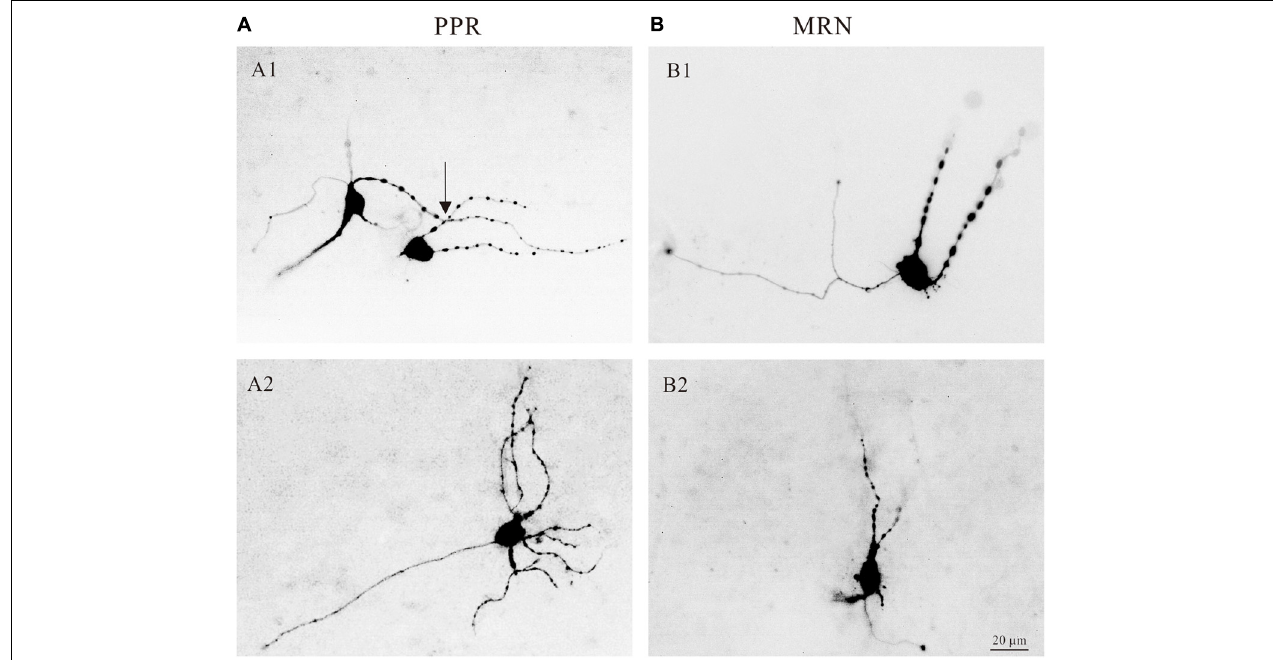
FIGURE 4 | Morphology of serotonergic (5-HT) neurons. (A1) Two 5-HT neurons labeled with intracellular tetramethylrhodamine and located in PPR. The dendrites of the neurons with large spherical varicosities crossing the dendrites of the neurons (arrow). (A2) Tetramethylrhodamine filled a 5-HT neuron located in PPR with large spherical varicosities. (B1,B2) Two 5-HT neurons located in MRN with large spherical